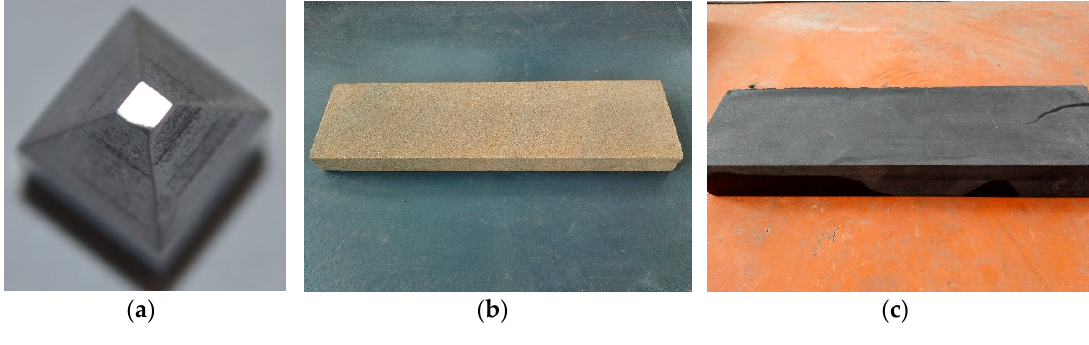
Figure 2. Specimens. ( a ) Alloyed steel; ( b ) sandstone; ( c ) shale. Table 2. The main characteristics of the experimental material.